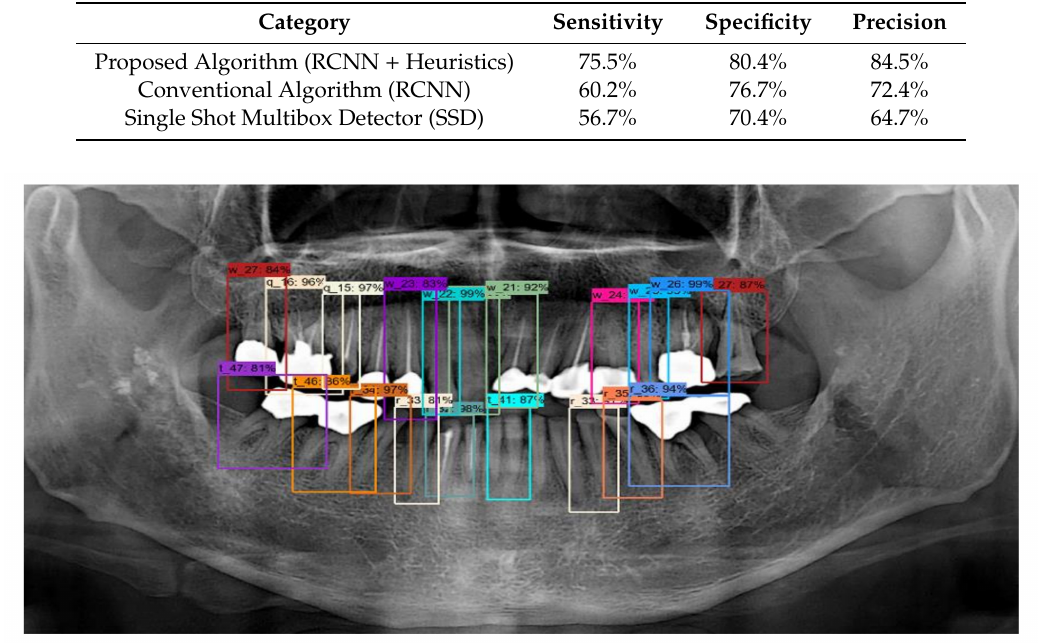
Figure 10. Results of tooth